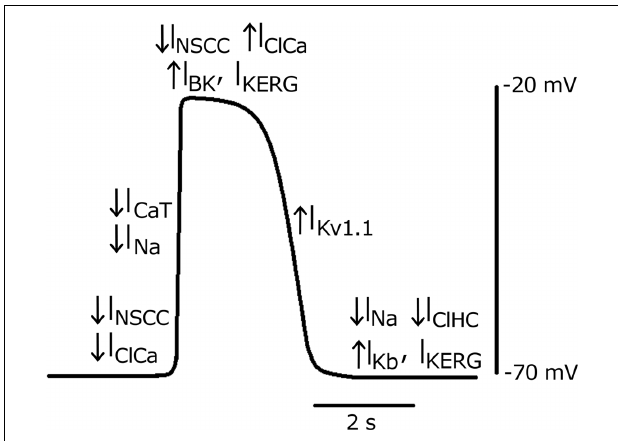
FIGURE 4 |A theoretical slow wave trace from human small intestine, with the ion currents contributing to the initial unitary potential, upstroke phase, plateau phase, repolarization, and resting potential. A downward arrow indicates an inward current, while an upward arrow indicates an outward current. I NSCC : Ca 2 + -activated NSC current, I ClCa : Ca 2 + -activated Cl − current, I Na : Na V 1.5 current, I CaT :T-type Ca 2 + current, I BK : Ca 2 + -activated K + current, I KERG : ERG K + current, I Kv1.1 : delayed-rectifier K + current,